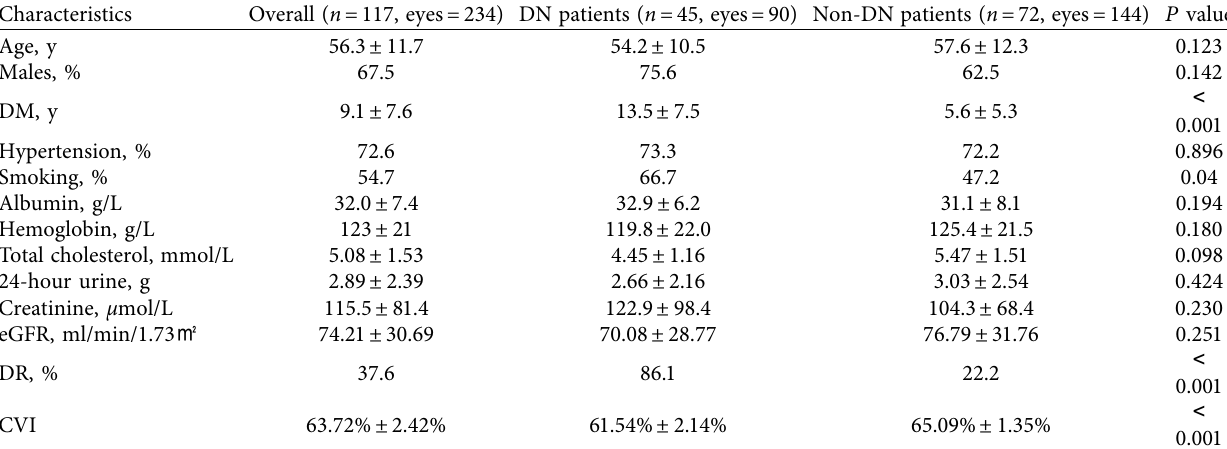
Table 1: Characteristics of the study population of participants with and without